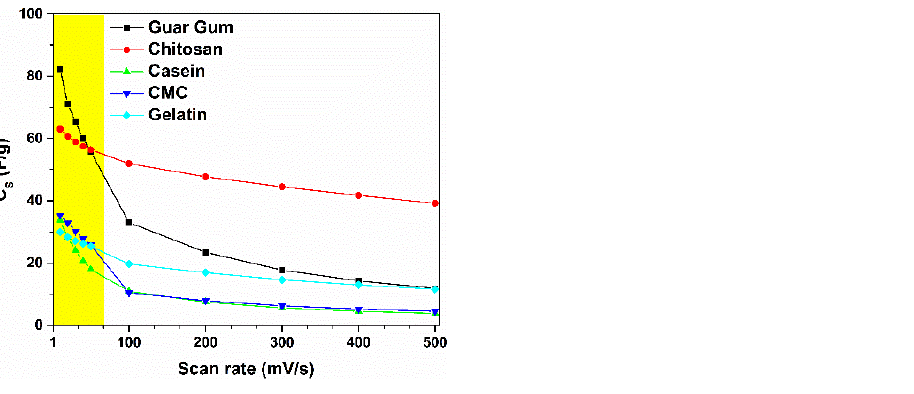
Figure 3. The gravimetric capacitance of the electrode binders investigated as a function of the scan rate.